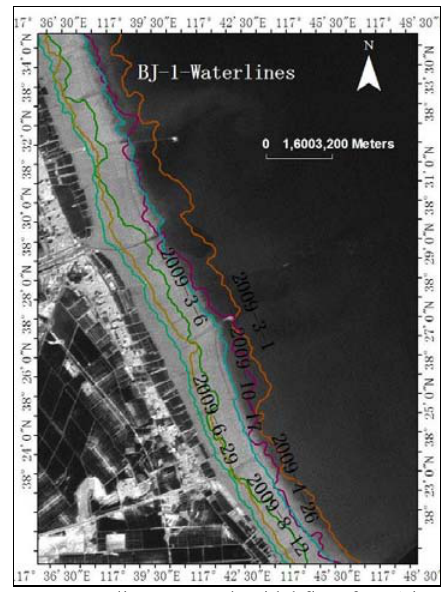
Figure.5 Waterlines set on the tidal flat of BJ-1 images